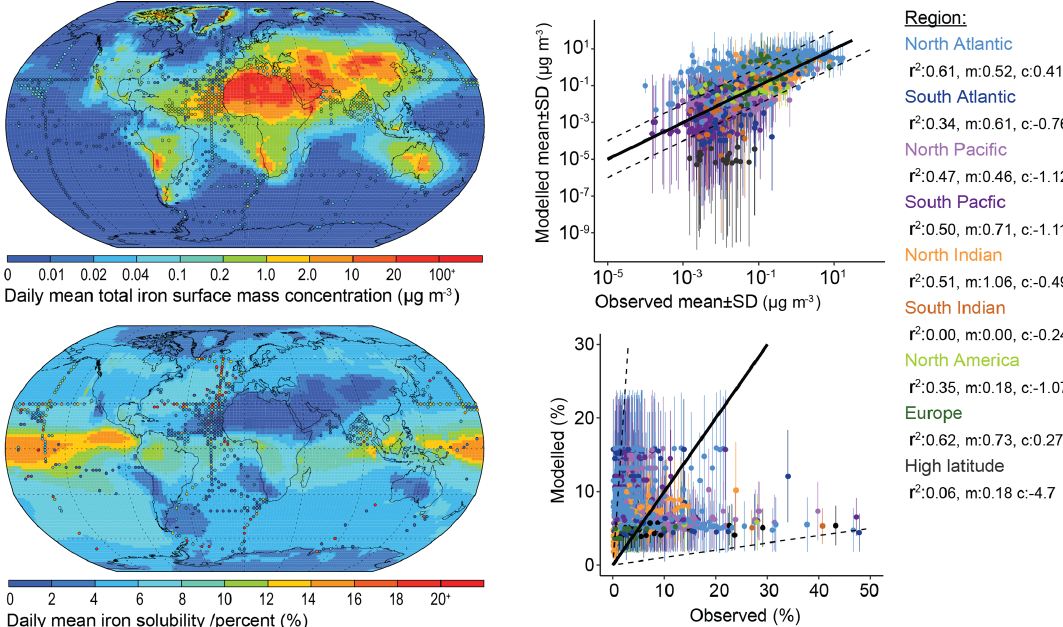
Figure 4. Daily mean model total iron concentration and solubility from 2007 to 2011. Observations (circles) overlaid (at resolution of the model grid) as a mean from 1524 individual records in Mahowald et al. (2009) and in Myriokefalitakis et al. (2018). Also shown are scatter plots of the model mean and standard deviation compared to each available observation and identified by oceanic region. Correlation ( r 2 ), gradient (m), and intercept (c) for total iron with observations shown for each region.